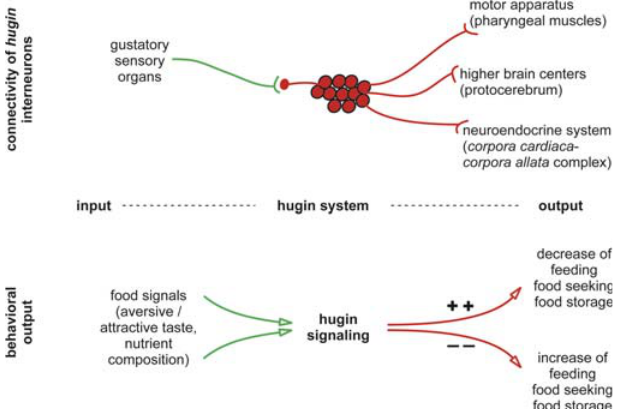
Figure 7. Model of hug as Modulator of Feeding Behavior The hug neurons, which express the neuropeptide gene hug and which interconnect gustatory sensillae via the SOG to the pharyngeal muscles, the protocerebrum, and the neuroendocrine organ, modulate chemo- sensory dependent feeding behavior. Increased hug signaling correlates with decreased feeding, whereas decreased hug signaling correlates with increased feeding (see Discussion section for details). DOI: